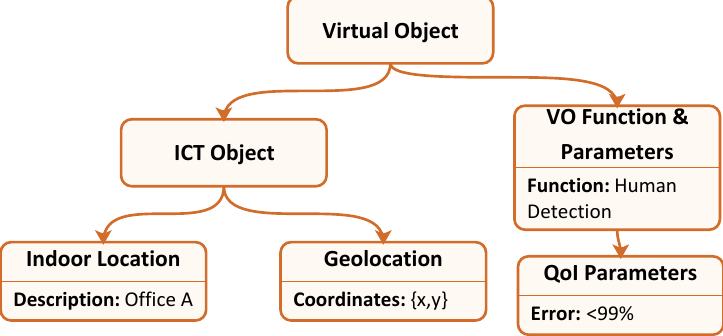
Figure 3. VO Information Model required to respond to the query coming from the Service Level, in the reference